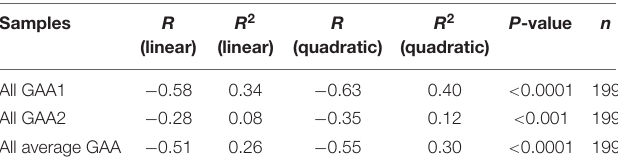
TABLE 2 | Summary of GAA repeat size versus age of onset correlation and regression analysis.